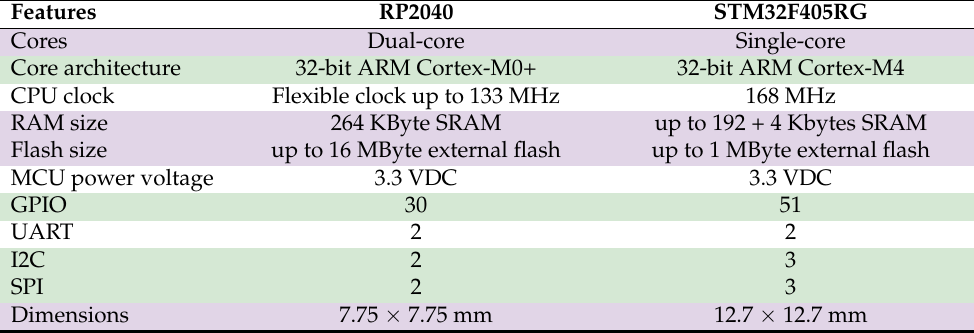
Table 3. RP2040 and STM32F405RG microcontroller